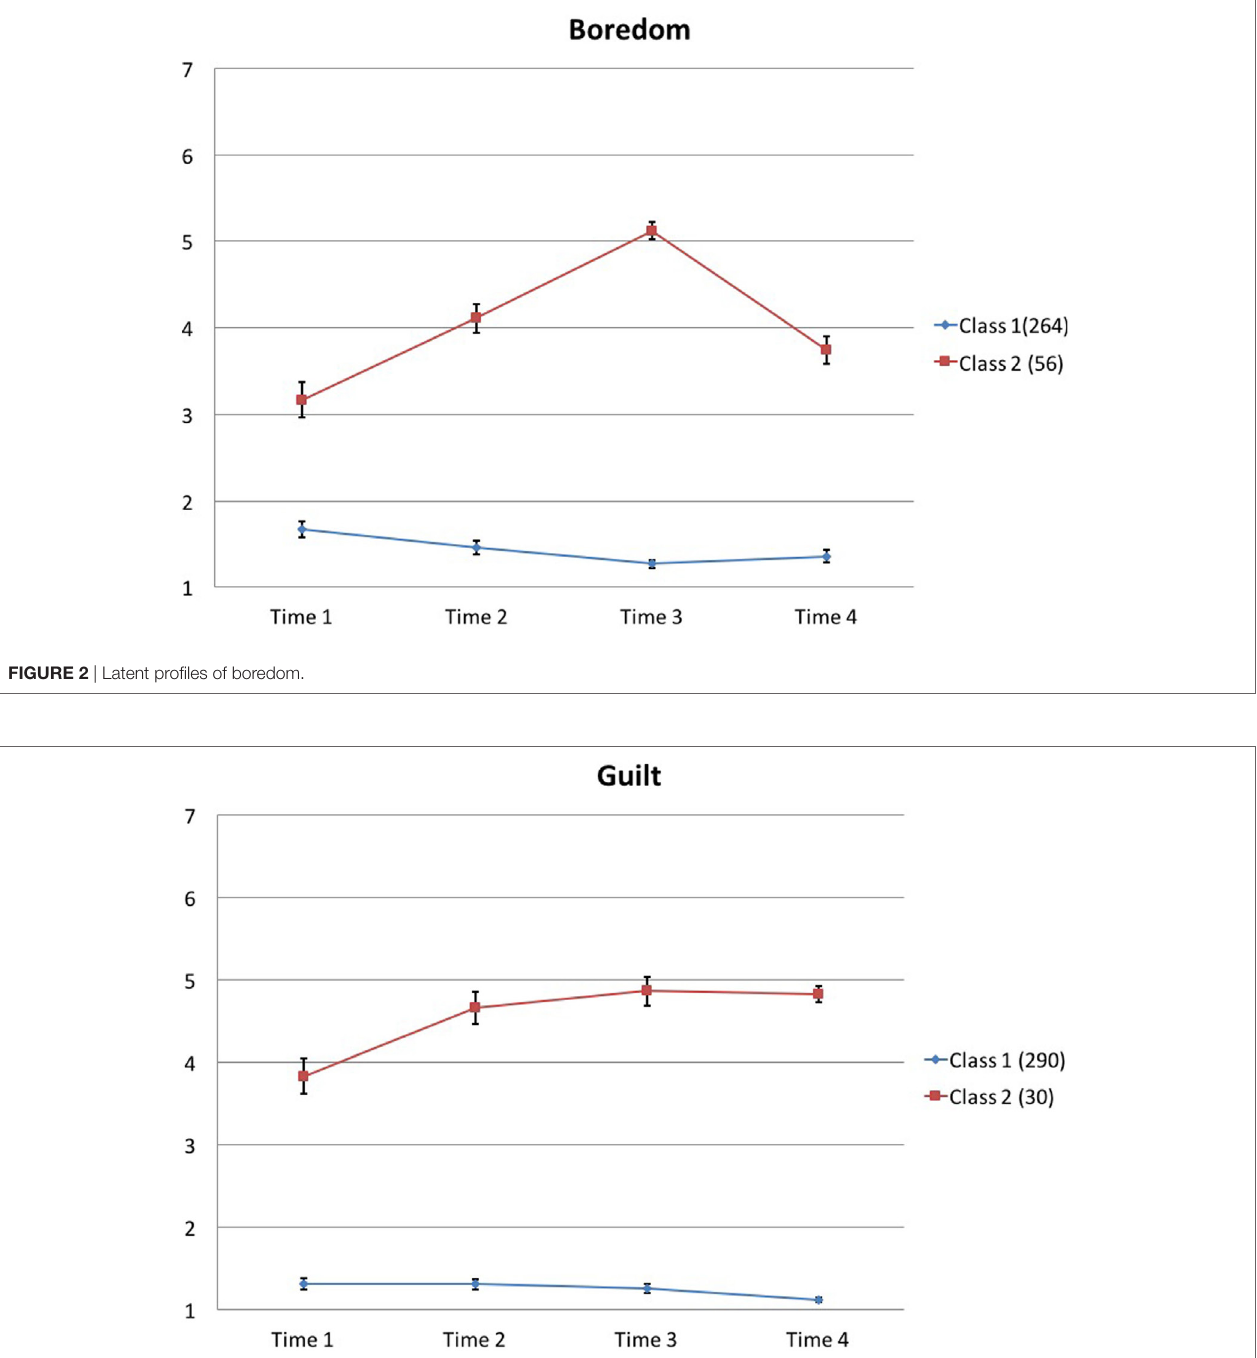
FigUre 3 | Latent profiles of